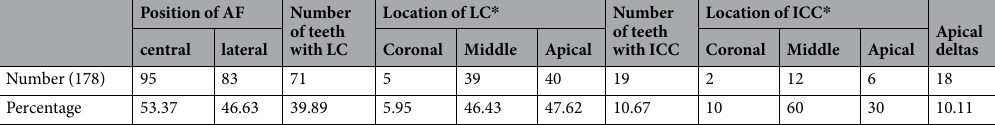
Table 2. Number of teeth with lateral canal, Intercanal communication or apical deltas and location of apical foramen, lateral canal or intercanal communication. AF: apical foramen; LC: lateral canal; ICC: Intercanal communication. * Some samples have more than one lateral canals or intercanal